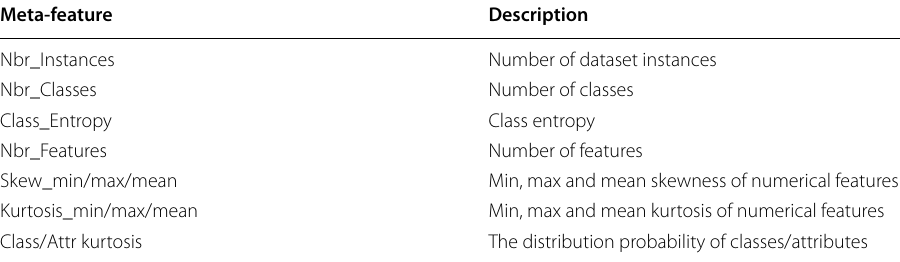
Table 4 A sample list of meta-features used in current